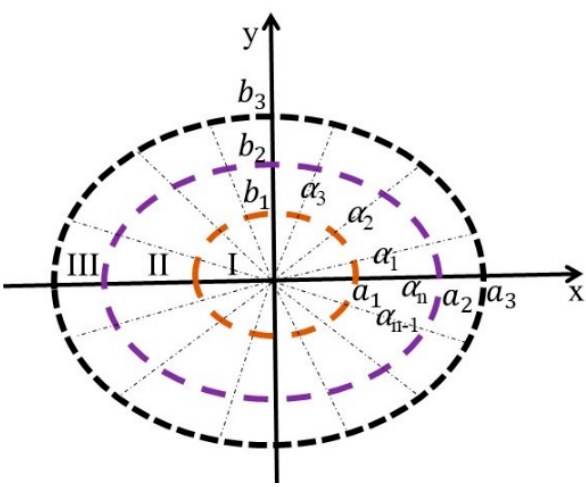
illumination area is divided into n parts along the direction α , where α i is the angle between i th part and the positive X axis.